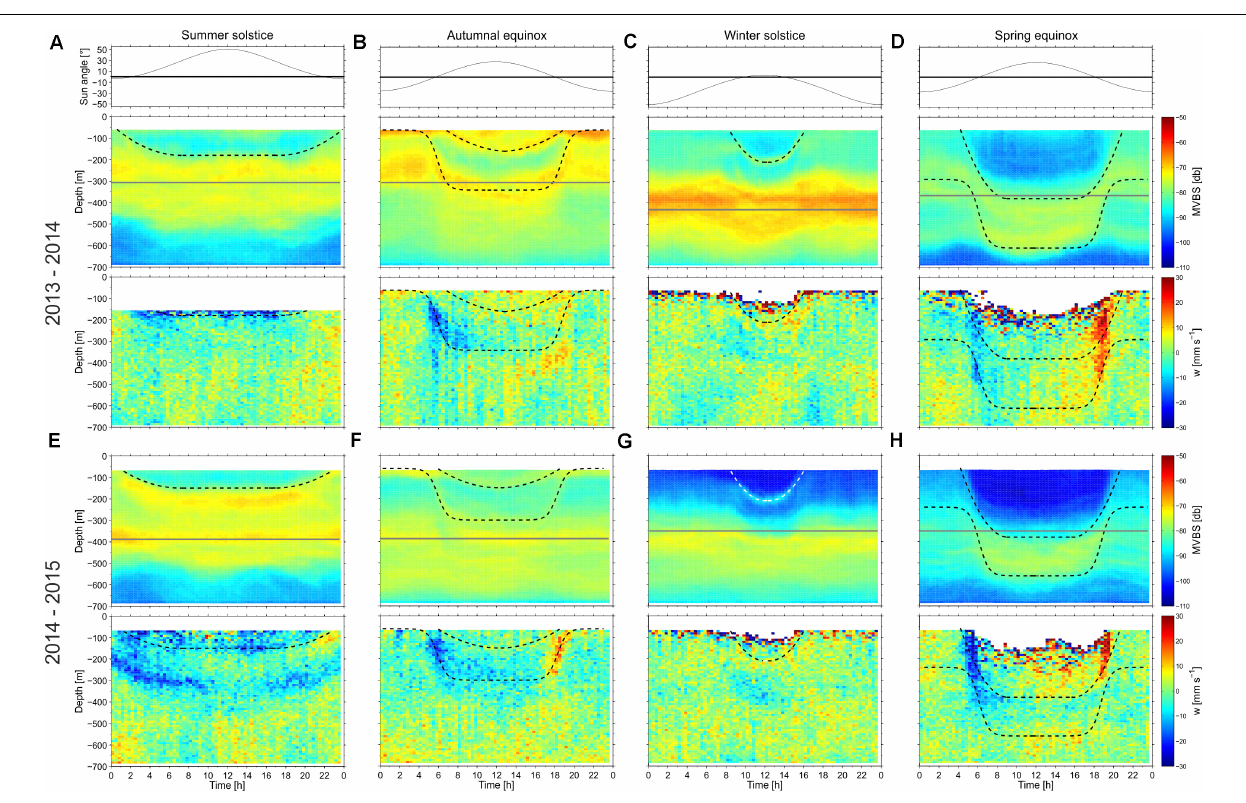
band in Figure 7 ). Similarly, the highest upward velocities are observed after sunset, and the ascent ceases about 1–2 h after sunset (green band). Negative values of w , related to downward migration, are evident throughout the year,